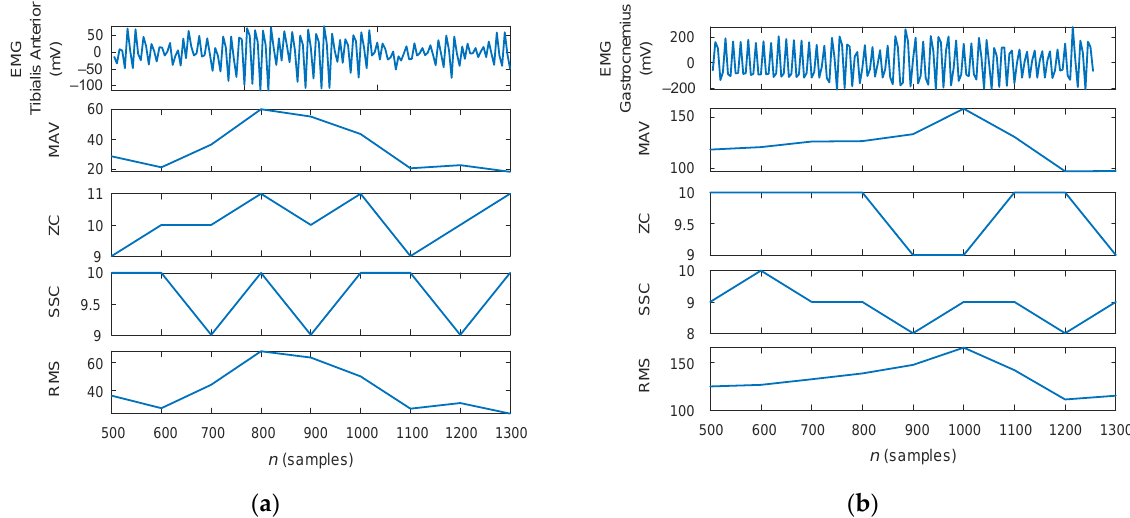
Figure 20. Muscular activation pattern determined based on the EMG extracted feature for ( a ) tibialis anterior and ( b ) gastrocnemius. The values of the EMG feature magnitudes, as read from Figure 20, discriminate walking form resting as prescribed by Table 4 (a 100 × multiplier was considered for MAV and RMS). This enables the evaluation of the FSR and EMG cross-correlation in the context of walking, aiming towards the decision upon physiological